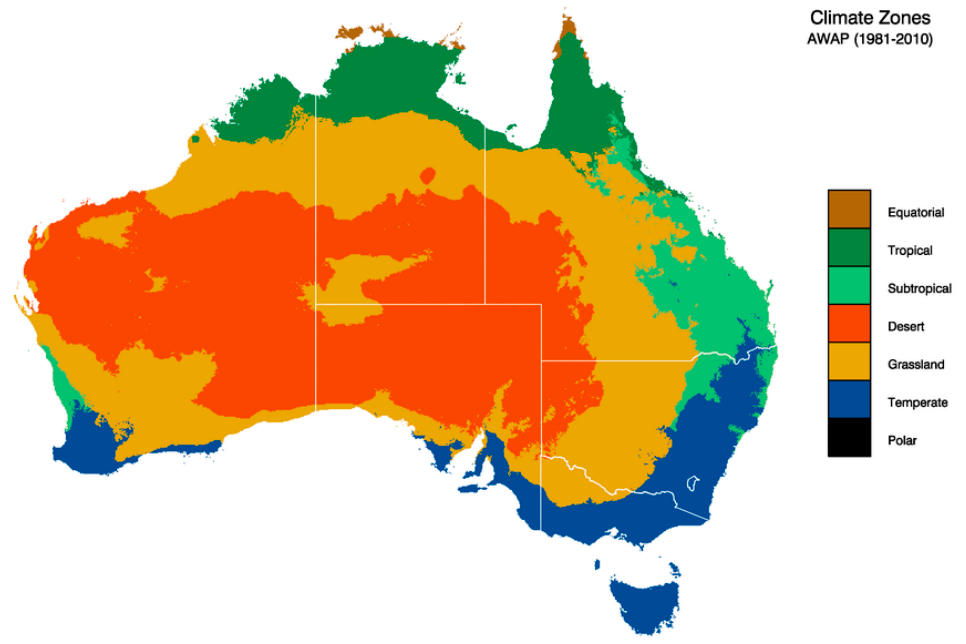
Figure 1. The Köppen climate classification for Australia.